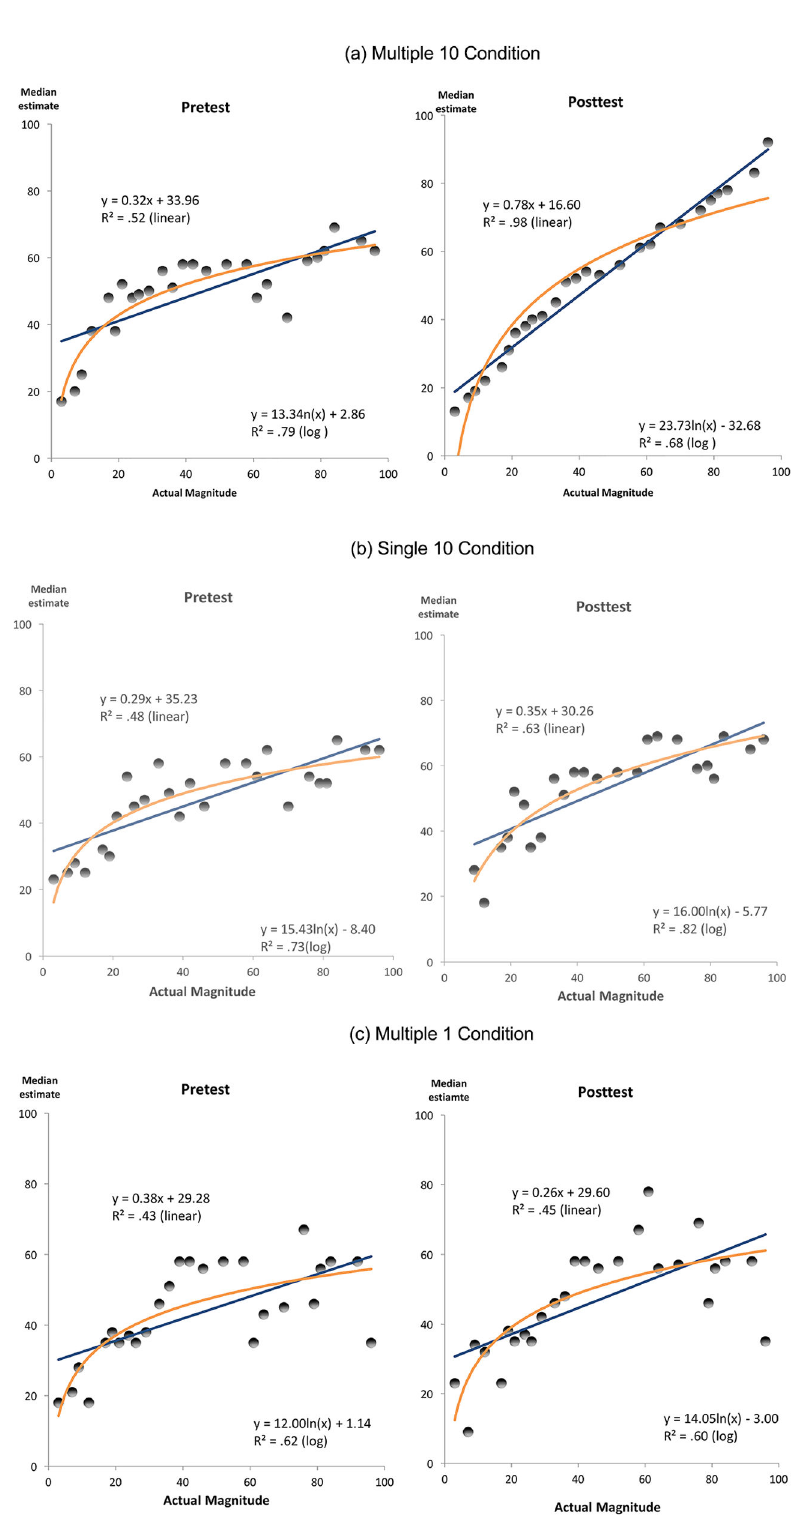
Figure 2. Median estimates of numerical magnitudes at pre- and posttests for the Multiple 10 (a), Single 10 (b), and Multiple 1 (c)